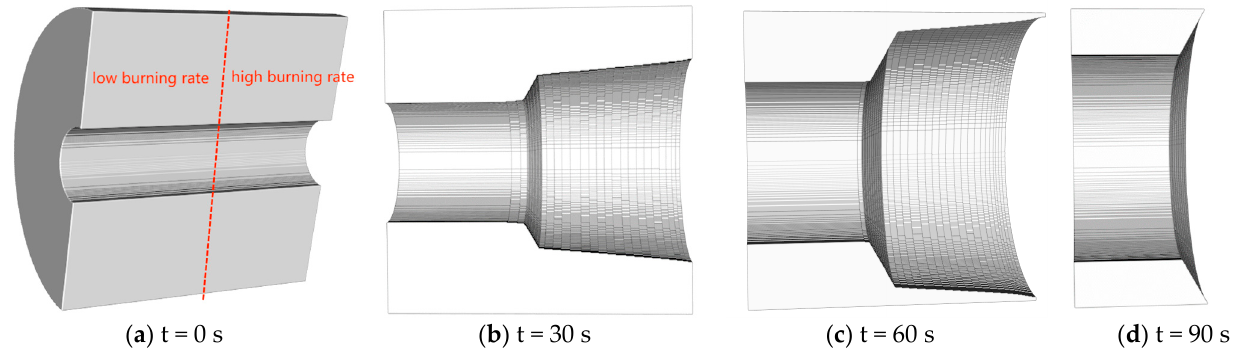
Figure 14. Burning process of double burning-rate tube grain.